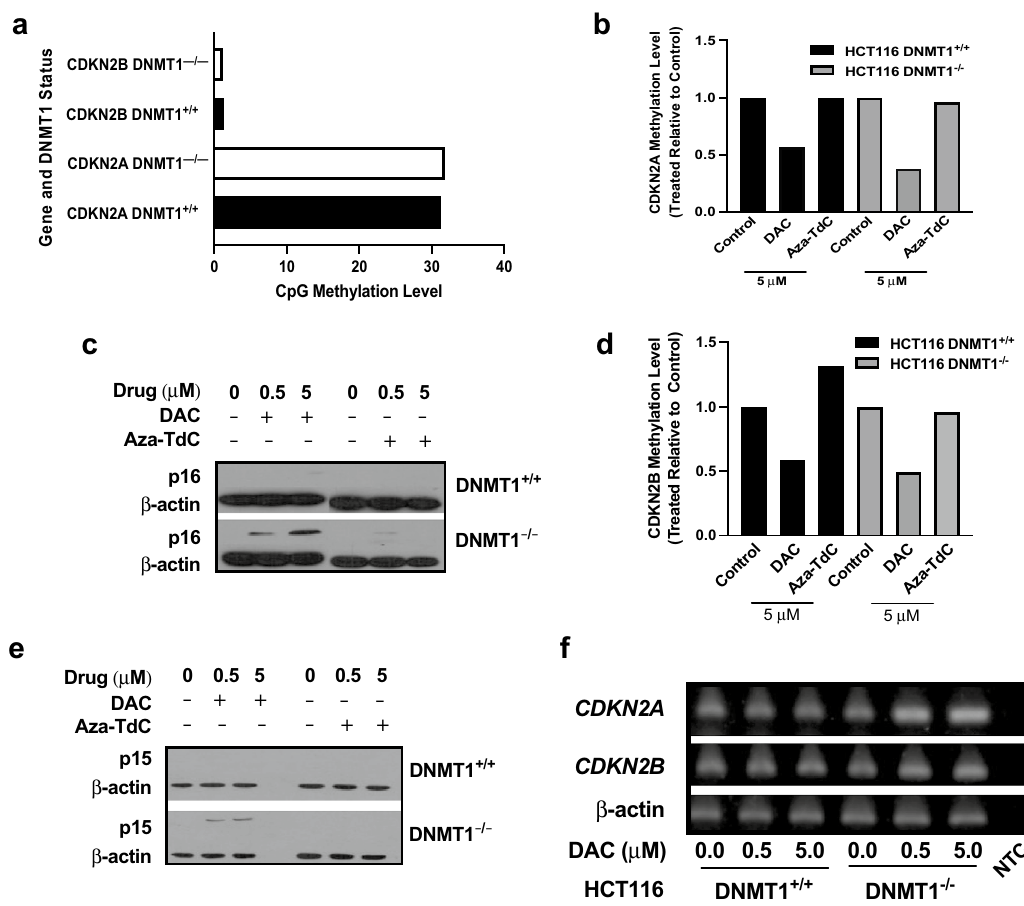
Figure 3. Demethylation of CDKN2A and CDKN2B genes, acetylation of histone H3, and re-expression of p16 INK4A and p15 INK4B by DNMTi in HCT116 cells. ( a ) Relative methylation levels (see Methods) of CDKN2A and CDKN2B in DNMT1 +/+ and DNMT1 −/− cells without treatment. ( b ) Methylation levels of CDKN2A gene promoter after exposure to DAC and aza-TdC. ( c ) p16 INK4A protein expression by DAC versus aza-TdC in DNMT1 −/− cells and no expression by both agents in DNMT1 +/+ cells. ( d ) Methylation levels of CDKN2B promoter upon exposure to DAC and aza-TdC. ( e ) Expression of p15 INK4B protein by DAC versus aza-TdCyd in DNMT1 −/− cells and no expression by both drugs in DNMT1 +/+ cells. ( f ) Chromatin immunoprecipitation demonstrating modulation of acetylation of histone H3 at CDKN2A and CDKN2B gene loci by DAC in DNMT1 −/− versus DNMT1 +/+ cells. NTC, no template control. All samples in methylation-specific PCR experiments were assayed in triplicate, with at least three independent experiments performed, and data were shown as the ratio of the average methylated DNA in treated to the control. One representative experiment is shown from at least three independent Chromatin immunoprecipitation Figs. 2c and 9c). The data suggest that re-expression of p16 INK4A and p15 INK4B is linked to an increase in histone- H3 acetylation at the gene loci, in addition to demethylation, in DNMT1 −/− cells. Expression of p16 INK4A and p15 INK4B was not reactivated in DNMT1 + / + cells without upregulating histone-H3 acetylation although CDKN2A and CDKN2B genes were demethylated by decitabine and azacitidine. The data suggest that suppression of p16 INK4A and p15 INK4B expression remain in place in the presence of DNMT1 at 72 h of drug treatment. Tumor growth inhibition and modulation of DNMT1 and p21 by DNMT inhibitors in animal models. To validate the in vitro findings, mice bearing HCT116 DNMT1 +/+ xenograft tumors were treated with decitabine and aza-T-dCyd as described in the Materials and Methods. Tumor samples with saline and drug treatment were collected at day 11 of the treatment cycles. The harvested tumors were quartered, in which one piece was formalin-fixed and paraffin-embedded and the cut-sections were used to assess the modulation of DNMT1 and p21. There were significant tumor growth delays, decreasing expression of DNMT1 and upregulat- ing expression of p21 by aza-T-dCyd and decitabine treatment in mice bearing xenograft tumors (Fig. 4a–c). The maximal tumor growth delays in HCT116- DNMT1 + / + model were observed at day 12 and day 18 by decitabine and aza-T-dCyd treatment, respectively. The tumor growth delay and inhibition of expression of DNMT1 and upregulation of p21 were also achieved by decitabine and aza-T-dCyd treatment in bladder PDX model (Sup- plementary Fig. 3a–c).